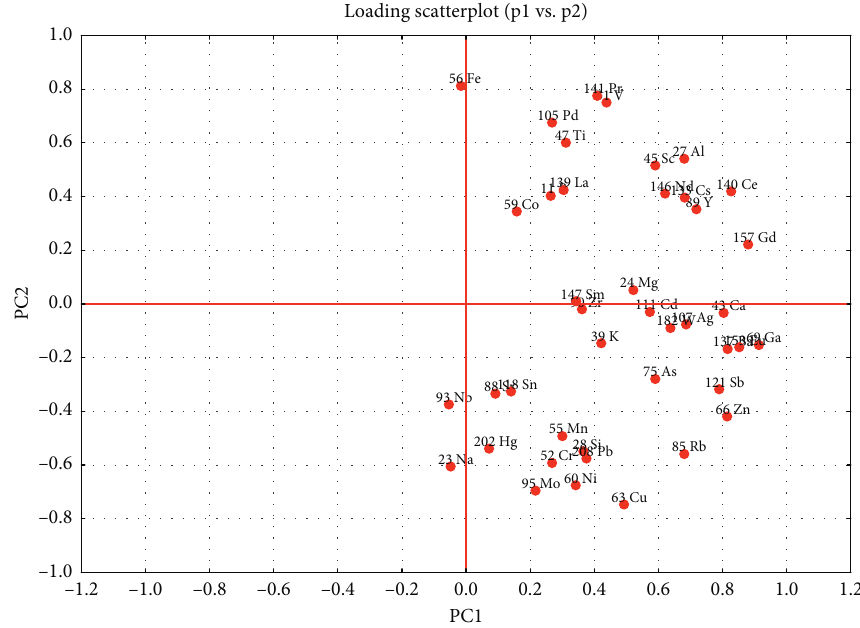
Figure 4: PCA loading scatterplots. X and moving R chart; variable: 28